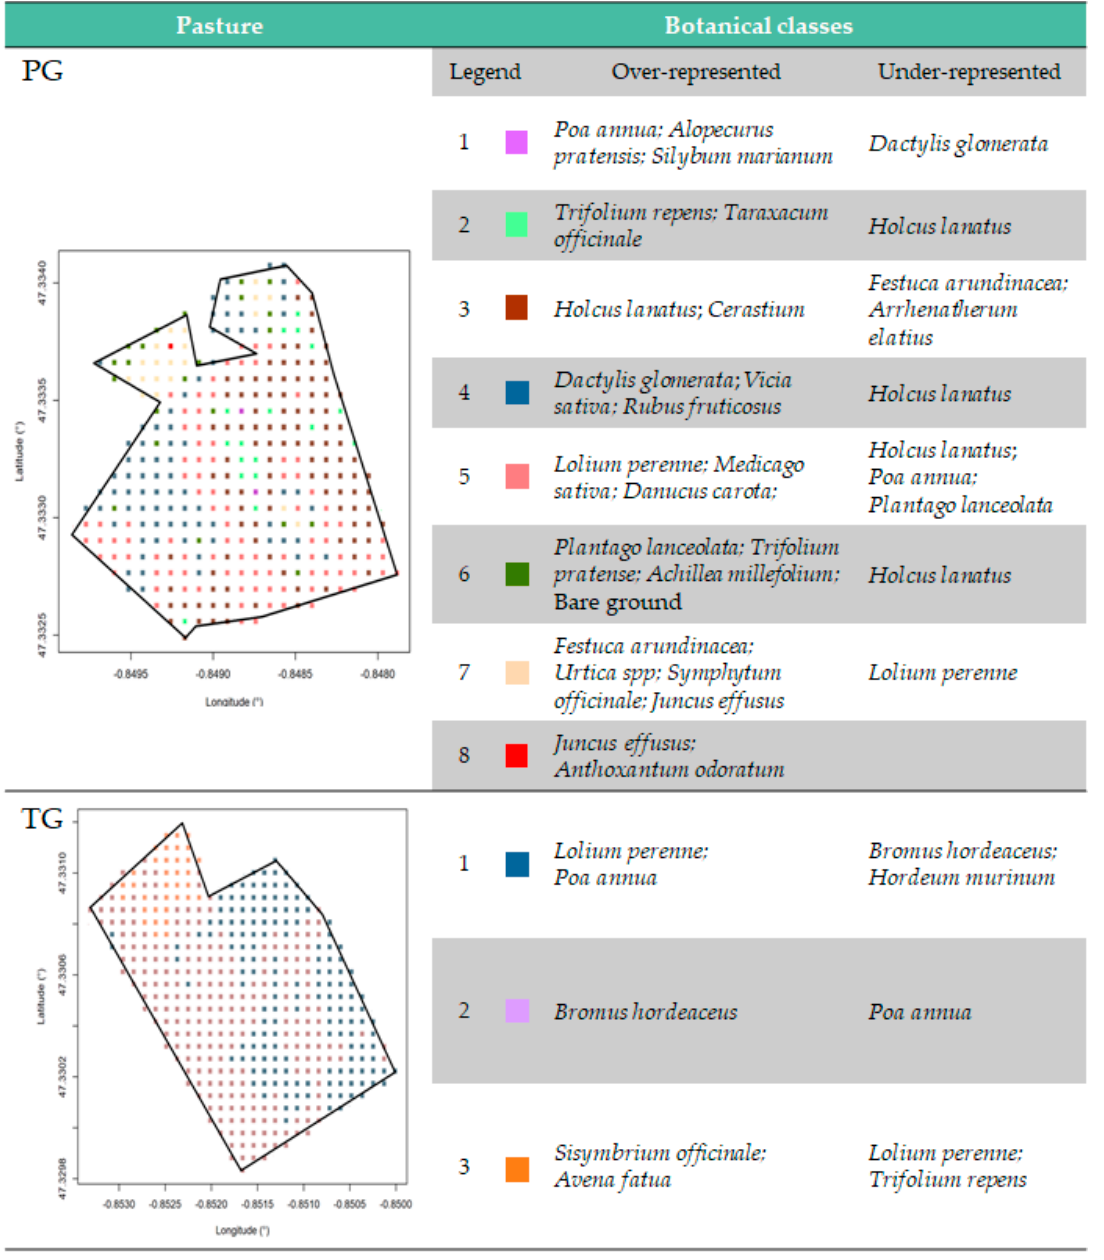
Figure 5. Description and geolocation of the botanical classes expressed with over-represented and under-represented plant species in the permanent grassland (PG) and temporary grassland (TG).